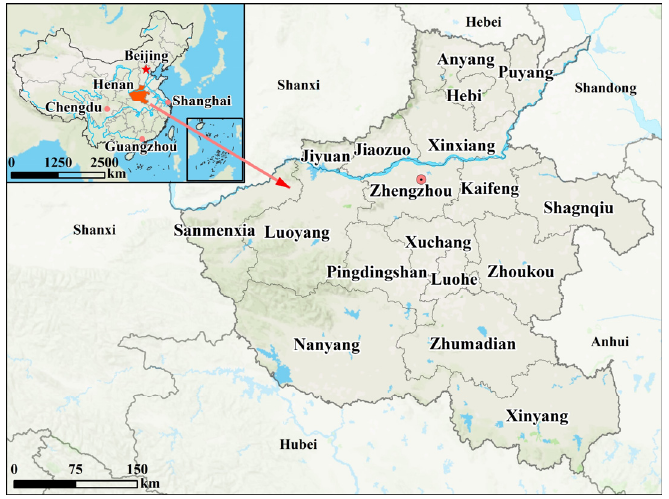
Figure 3. Location and subregions of Henan province.